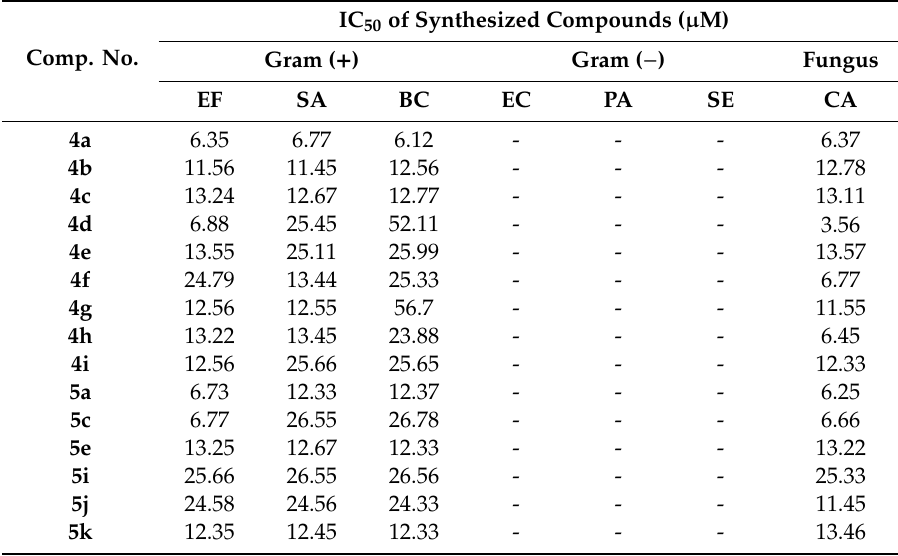
Table 3. IC 50 of synthesized hydrazide-hydrazones 4a – i and 5a – k .